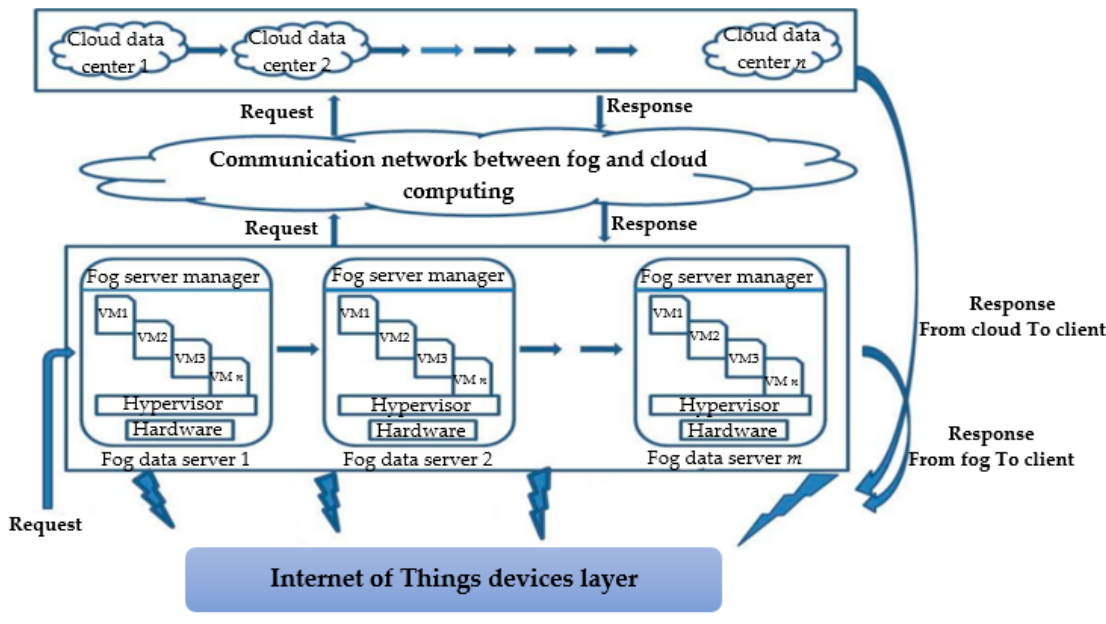
Figure 7. Scheme of the hypervisor mechanism process in a cloud.